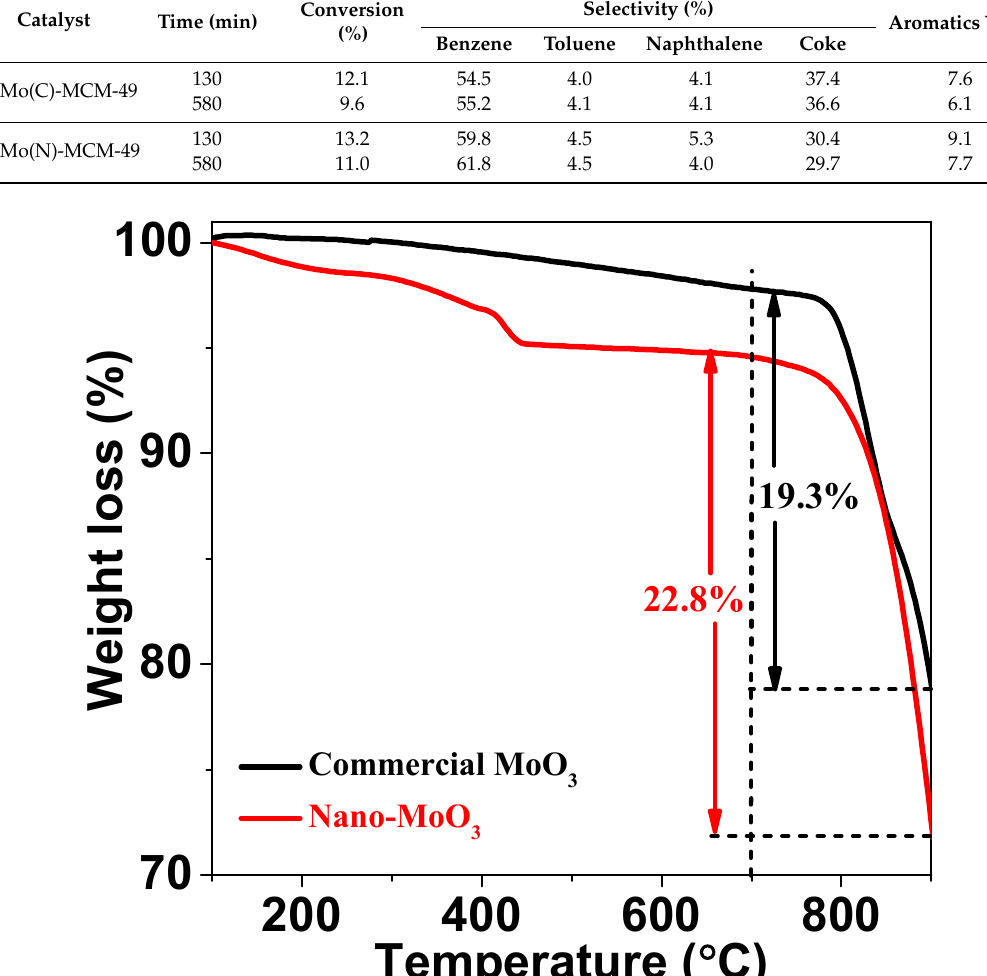
3 and ano-MoO 3